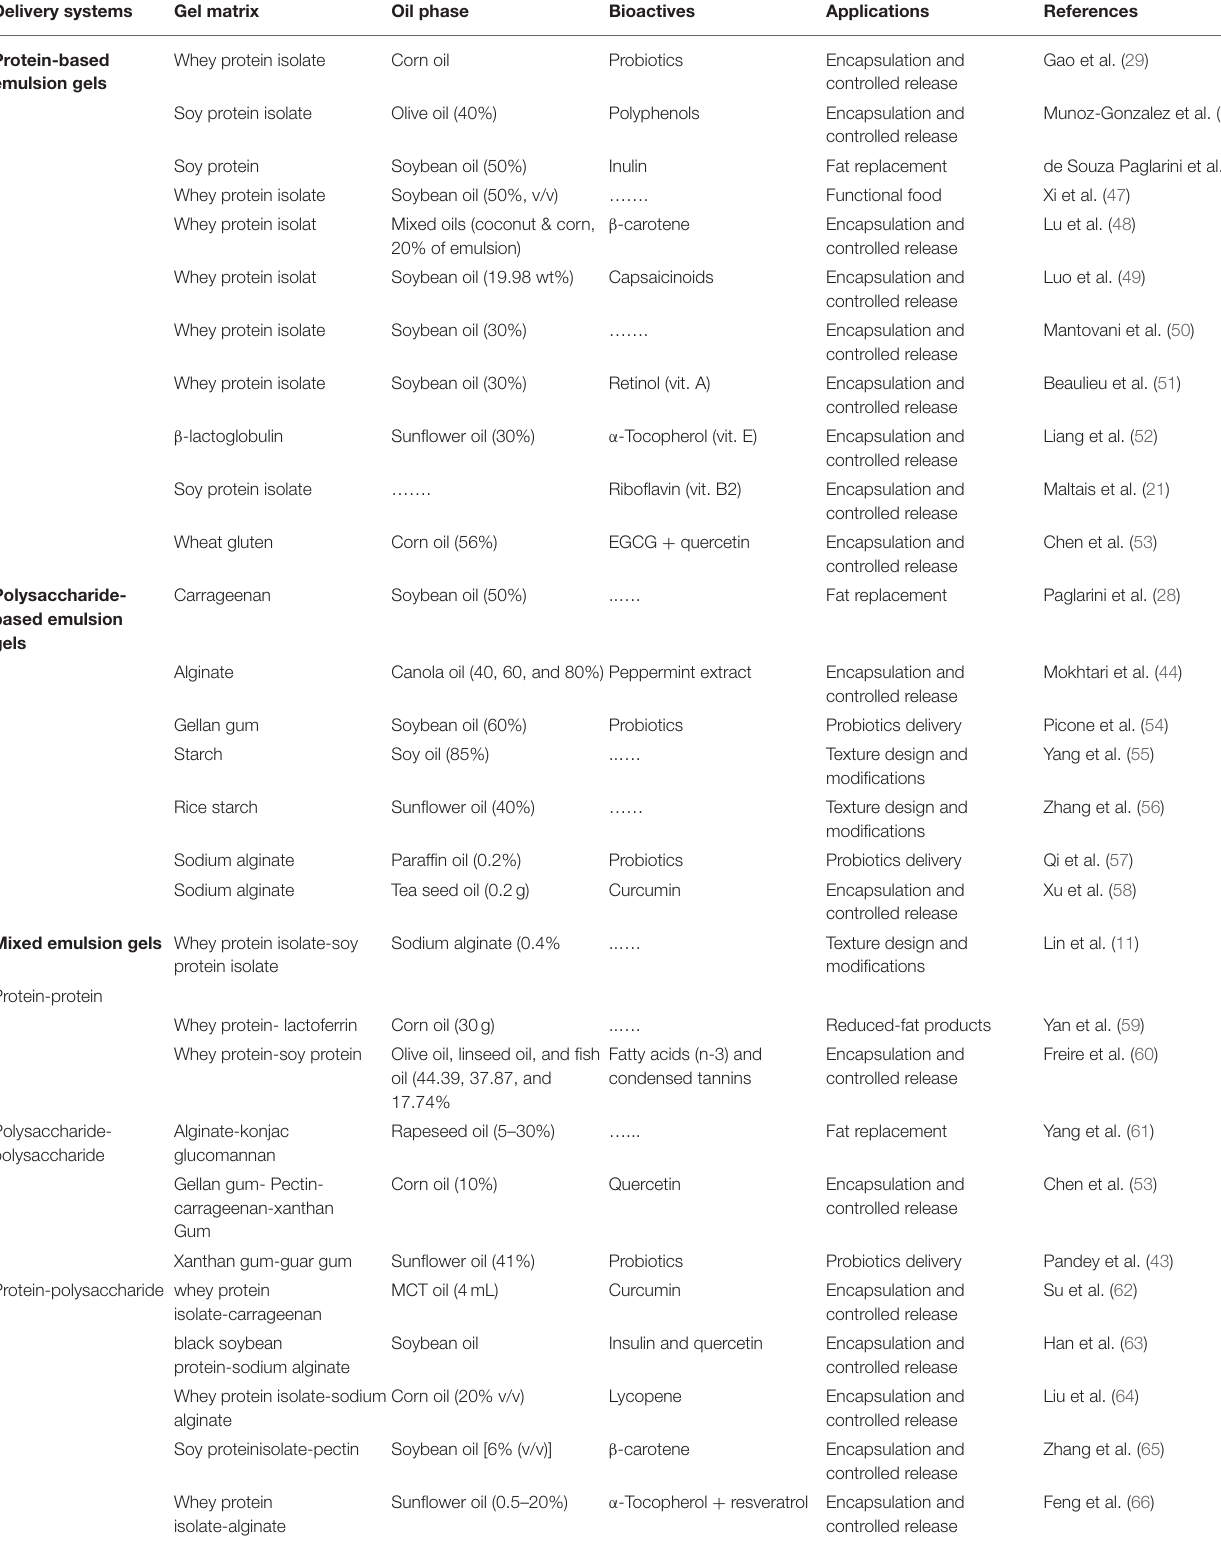
TABLE 1 | Gel-based functional delivery systems, including protein-, polysaccharide-, and mixed emulsion gels (emulgels). Delivery